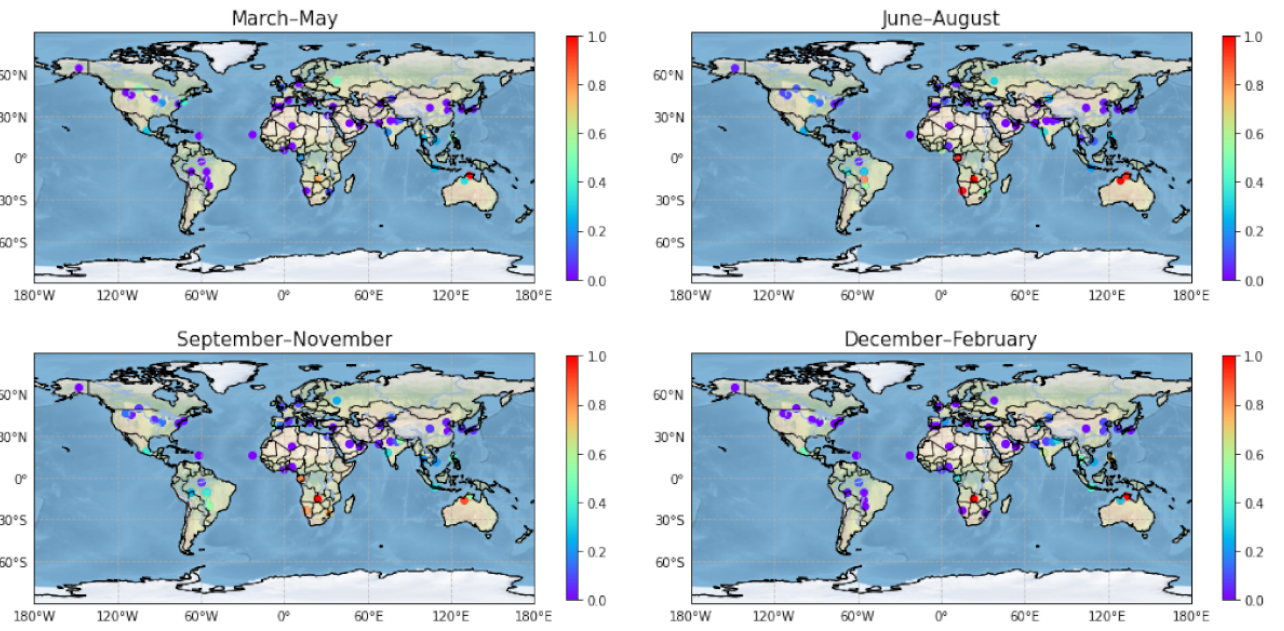
Figure 6. Temporal distribution of strongly absorbing aerosols. The color dot in each station implies the values of occurrence frequency in the color